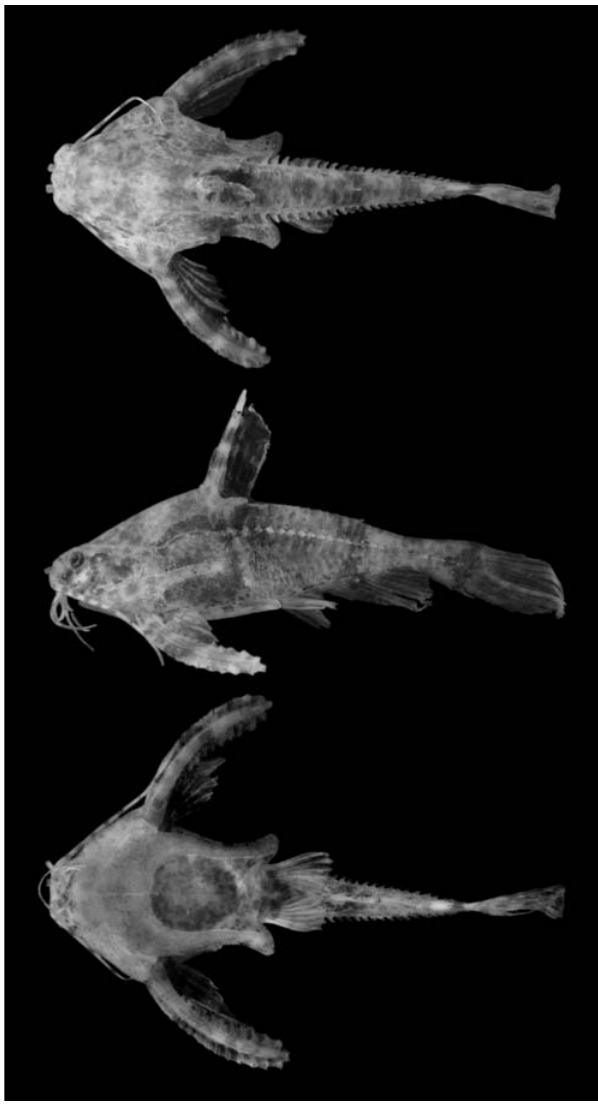
Fig. 4. Physopyxis lyra , ANSP 167615 (26.35 mm SL), río Nanay, Loreto, Peru.